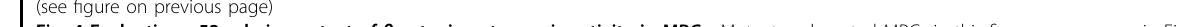
Fig. 5A, Osx was mostly localized outside the nuclei of XAX939-treated MPCs, in contrast to vehicle-treated MPCs (Fig. 5B). In addition, the β -catenin – Tm + C-MPCs from X/CKO Tomato mice exhibited Osx cellular localization pattern (Fig. 5C) similar to the β -catenin – Tm + (Fig. 5A) and the XAX939-treated MPCs (Fig. 5B). β